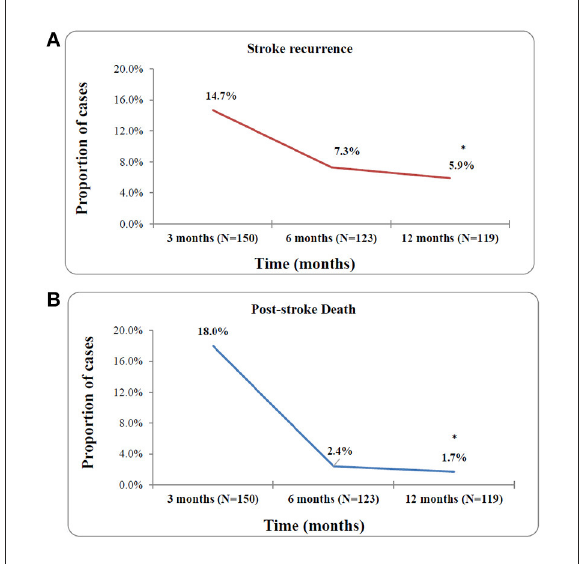
FIGURE3 Risk rates of stroke recurrence (A) and any-cause of death (B) at 3, 6, and 12 month post-stroke. * p -value < 0.001.